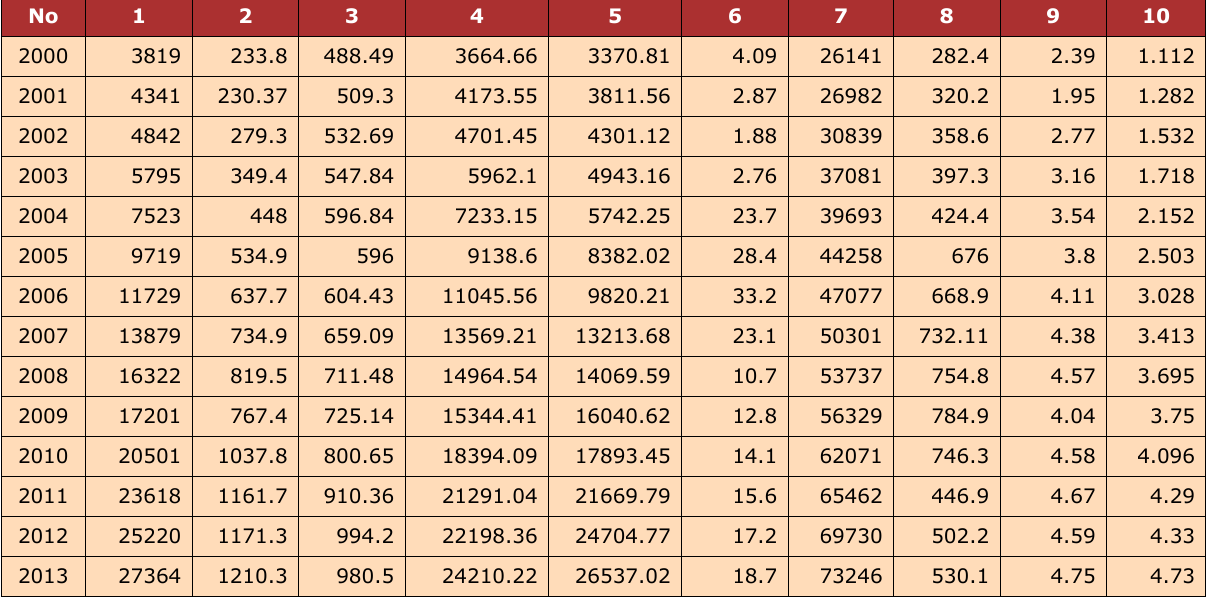
Table 2. Original Data of the Throughput of Guangzhou Port